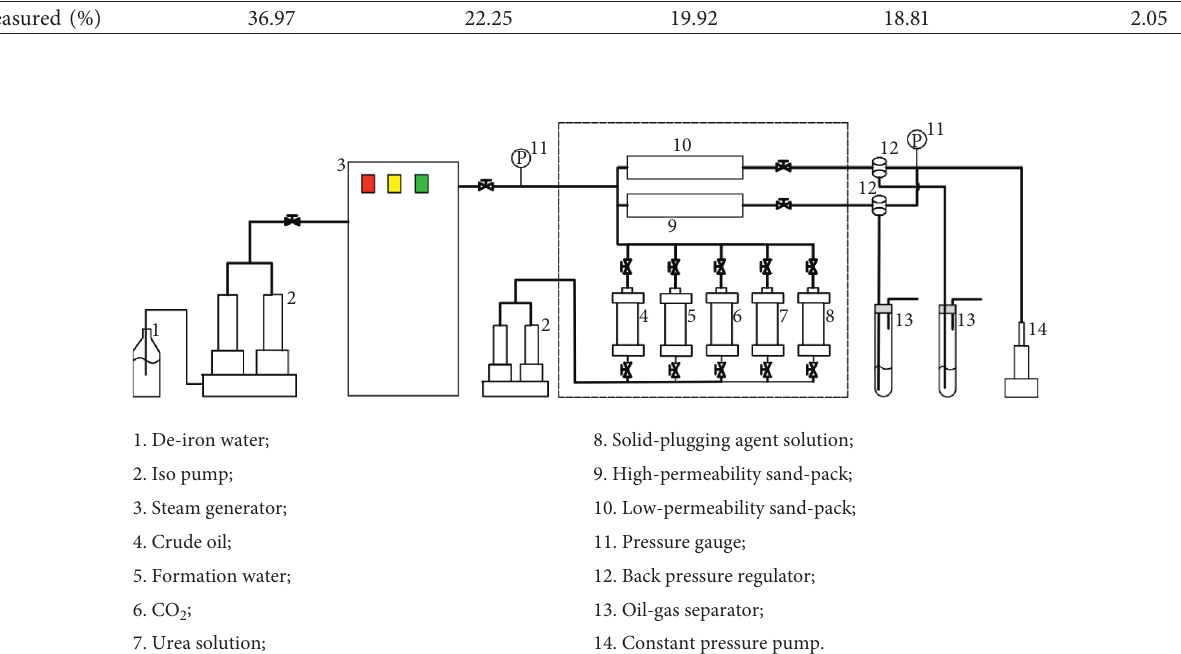
Figure 2: Schematic of multimedia-assisted steam flooding process. (1) De-iron water; (2) iso-pump; (3) steam generator; (4) crude oil; (5) formation water; (6) CO 2 ; (7) urea solution; (8) solid plugging agent solution; (9) high-permeability sand pack; (10) low-permeability sand pack; (11) pressure gauge; (12) back pressure regulator; (13) oil-gas separator; and (14) constant pressure